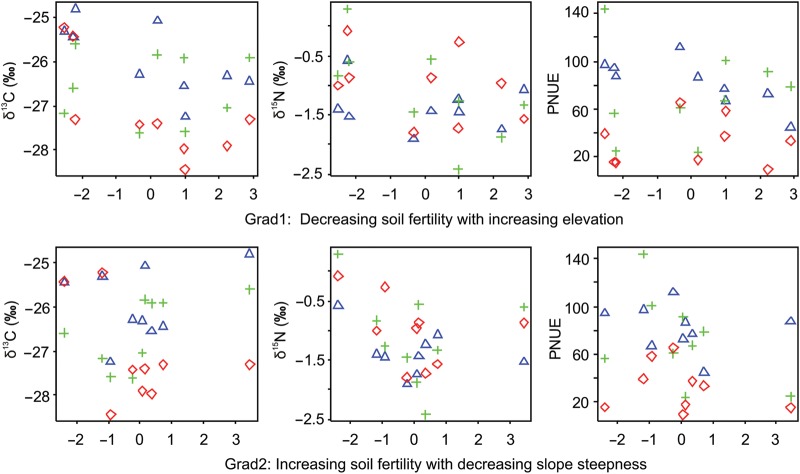
Relationships between key leaf traits related to long-term resource-use efficiency in the rare cycad D. sonorense and the main measured environmental gradients. Symbols represent mean values per life stage in the nine studied populations, as follows: triangle, adult; cross, juvenile; and rhomboid, seedling stage. Abbreviations: δ13C, carbon stable isotope ratio, used to infer long-term water-use efficiency; δ15N, nitrogen stable isotope ratio, used to infer reliance on symbiotic nitrogen fixation; and PNUE, photosynthetic nitrogen-use efficiency.